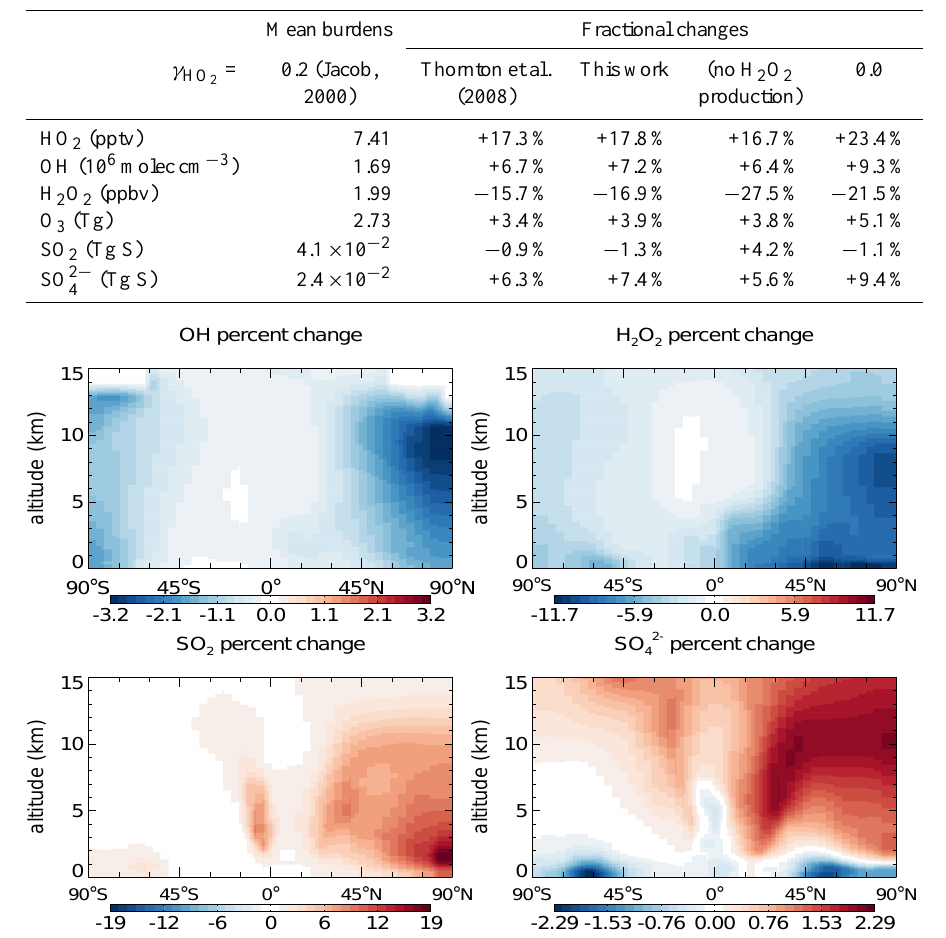
Fig. 7. Impact of not producing H 2 O 2 from the heterogeneous reaction of HO 2 , using γ HO